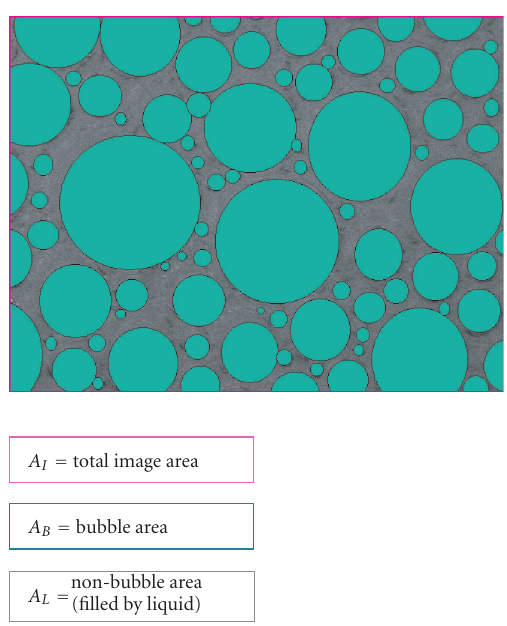
Figure 3.13. Determination of the liquid fraction of foam from a foam image taken as snapshot of shrinking beer foam with trapped bubbles areas.